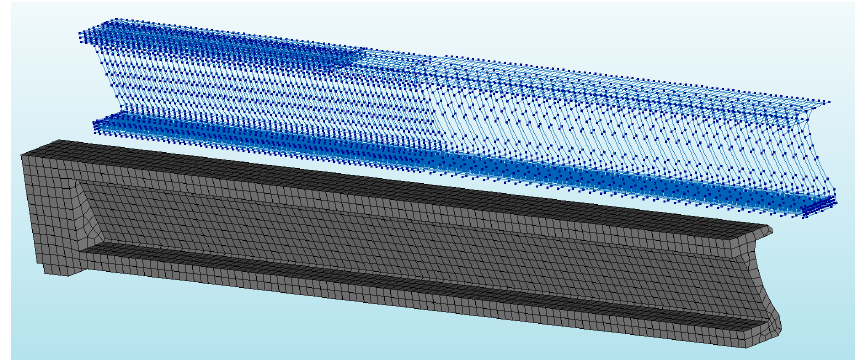
Figure 11. Three-dimensional (3D) finite element (FE) model for the medium-span PSC girder.